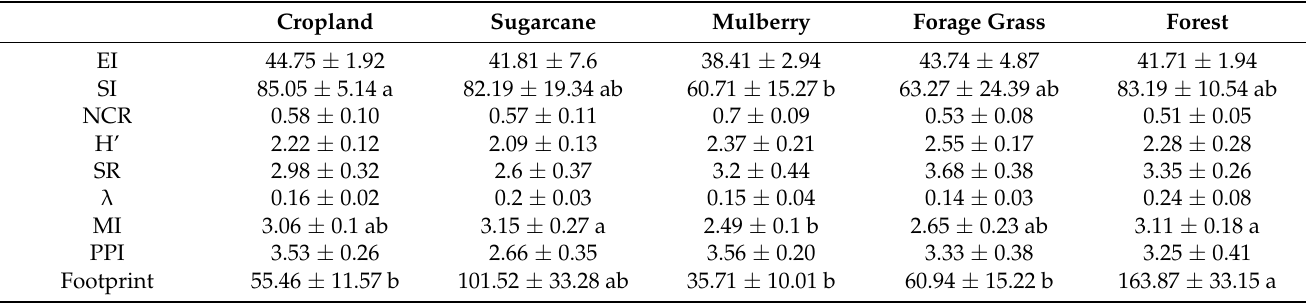
Table 1. Nematode community indices of five land-use types: cropland, sugarcane, mulberry, forage grass, and forest.